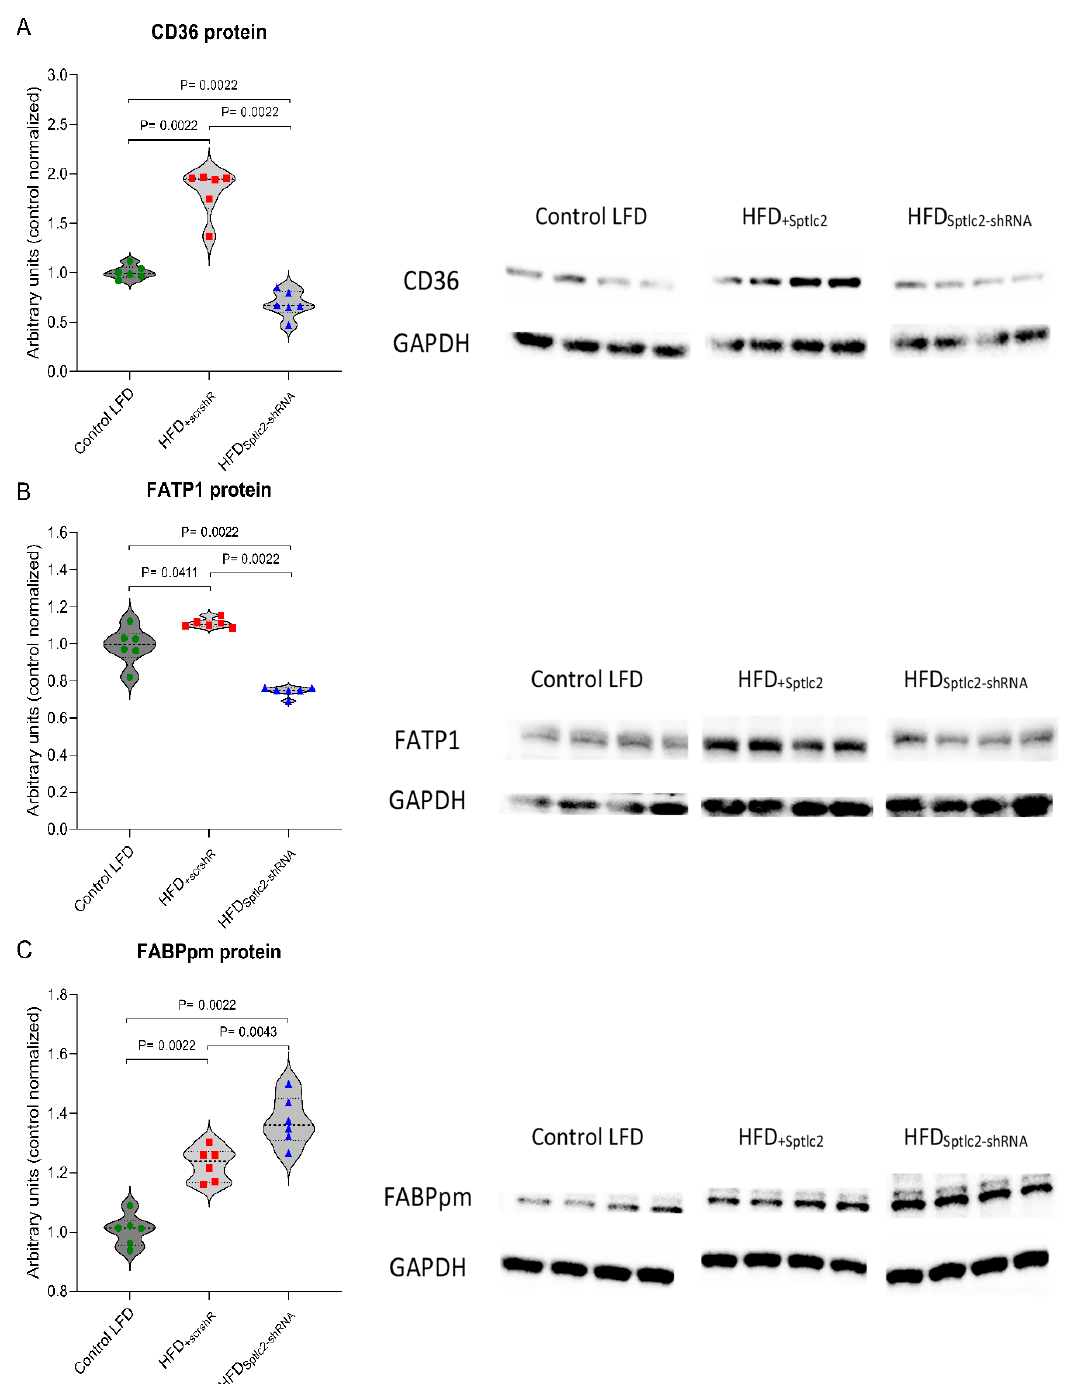
Figure 3. ( A – C ) The impact of skeletal muscle Sptlc2 silencing on the protein expression of fatty acid transporters in the gastrocnemius muscle of high-fat diet mice: ( A ) protein expression of CD36; ( B ) protein expression of FATP1; ( C ) protein expression of FABPpm. Significance by Mann–Whitney U test. The figures show the median and interquartile range ( n = 6). The observed molecular weights of the indicated proteins are different from the theoretical values, as stated by the anti- body manufacturer. Green circles—values for individual Control LTD gastrocnemius muscles; Red squares—values for individual HFD +scrshRNA gastrocnemius muscles; Blue triangles—values for individual HFD Sptlc2-shRNA gastrocnemius